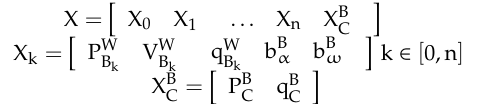
Figure 5. Adjust the position of the projection block 𝑢 𝑖′ on the current frame to minimize the photometric error of the projection block in the current frame and the reference frame in the sliding window.